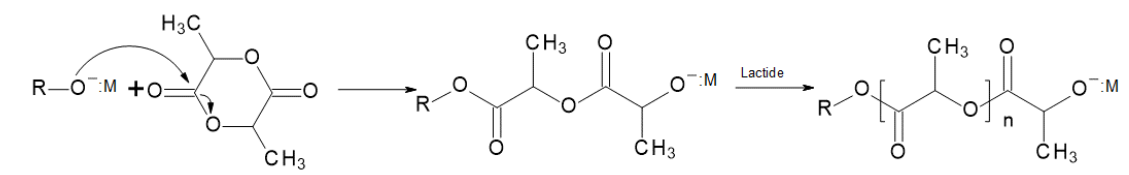
Figure 11. Anionic ring-opening polymerization mechanism for PLA [5].